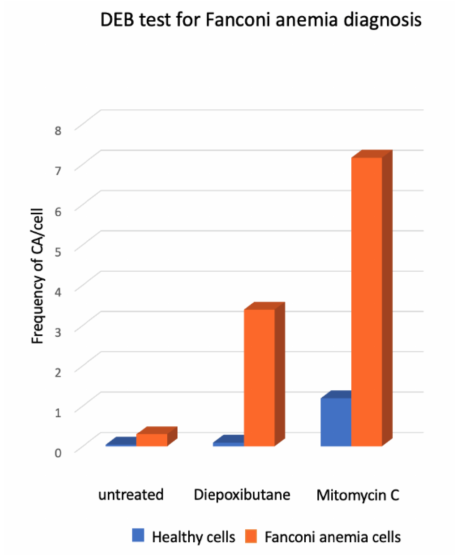
Figure 5. Response of lymphocytes from FA patients ( n = 18) and healthy subjects ( n = 117) to treatment with ICL inducing agents, Diepoxybutane [0.1 µ g / mL] and mitomycin C [40 ng / mL]. Gross